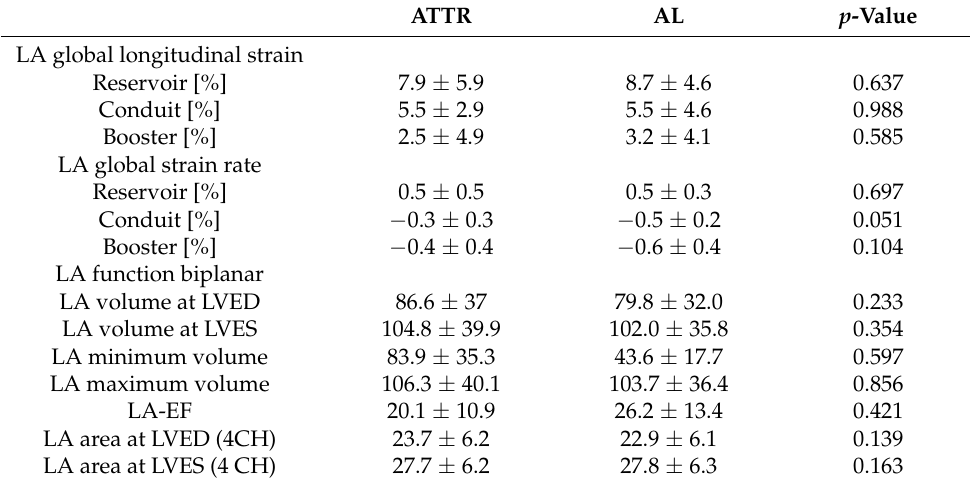
Table 5. Left atrial functional parameters in ATTR and AL.